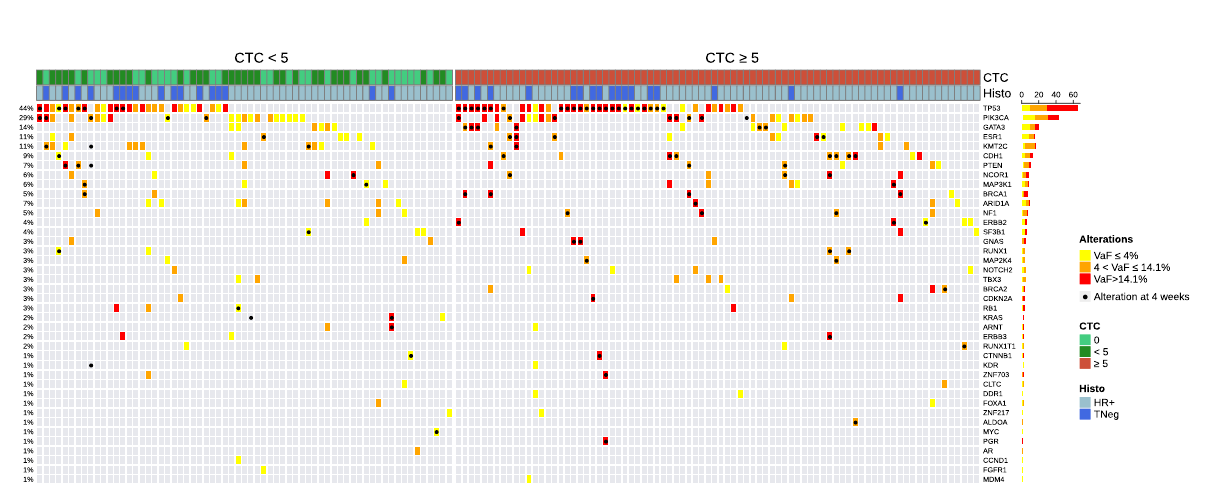
Fig. 1 Variant-detection rate in cfDNA according to CTC numbers at baseline ( n = 147). Variant-detection rates are displayed for each gene at baseline ( n = 147 patients). VAF is colored by quartiles with higher VAF (>14%) in red, middle VAF (4 < VAF ≤ 14%) in orange, and lower VAF in yellow ( ≤